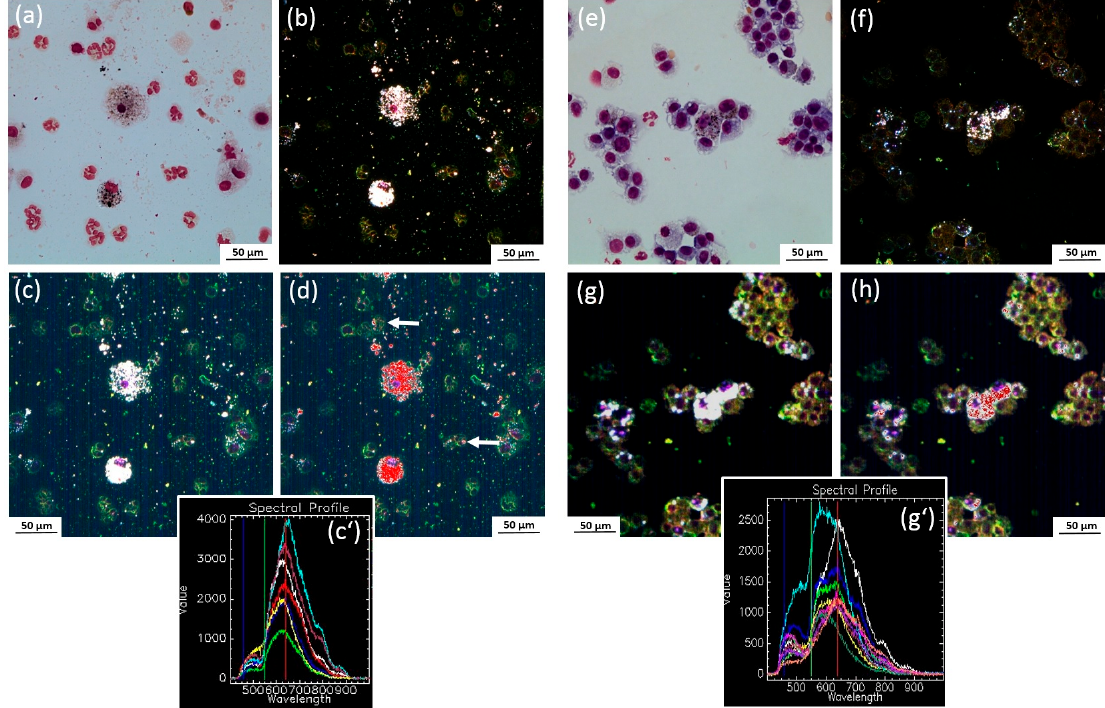
Figure 9. Identification of Ag50-PVP in Pappenheim-stained cytospin preparations from rat BALF. Rats were instilled with 150 µg Ag50-PVP per lung and lavaged after three ( a – d ) and 21 days ( e – h ). ( a , e ) Brightfield images showing alveolar macrophages and neutrophilic granulocytes; ( b , f ) corresponding dark field images; light-scattering material is contained in alveolar macrophages; ( c , g ) corresponding images from hyperspectral microscopy ; ( c’ , g’ ) spectral libraries of Ag50-PVP as collected from macrophages laden with light-scattering material; ( d , h ) matching of the spectral libraries as shown in c’ and g’ with the spectral angle mapping (SAM) method reveals Ag50-PVP (superimposed in red) in macrophages and, to a lower extent, in some neutrophilic granulocytes (arrows in d ).